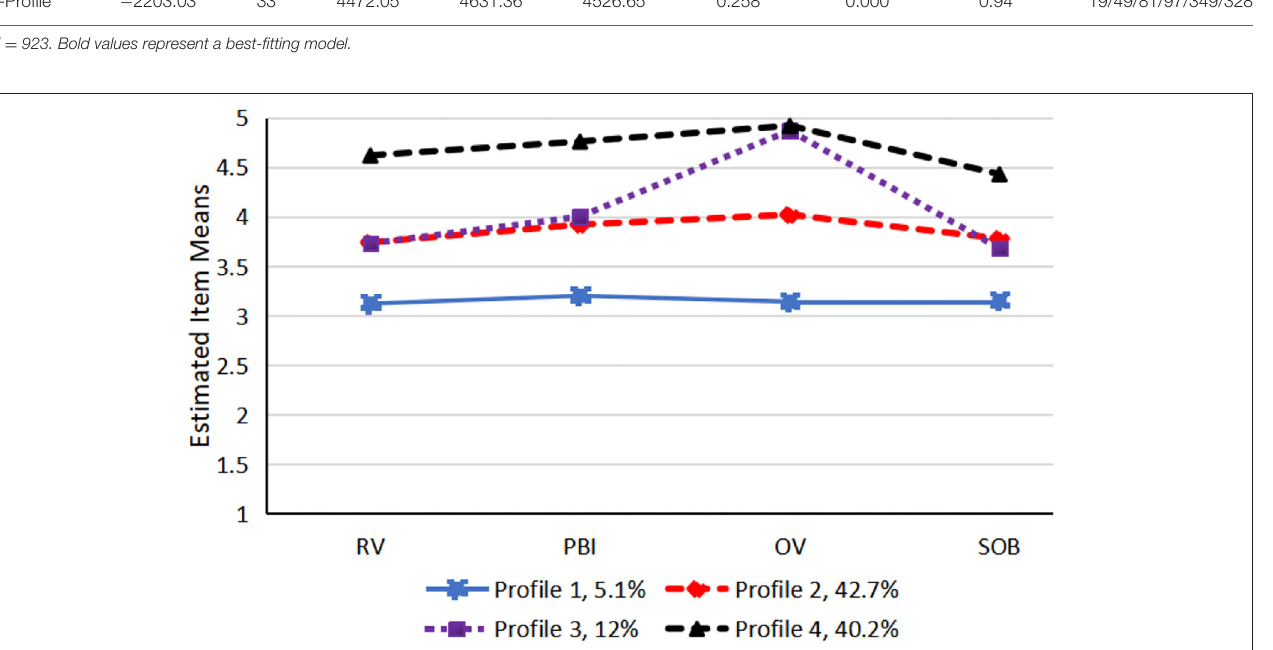
FIGURE 1 | Four-profile solution of teachers’ professional identity. RV, role values; PBI, professional behavior inclination; OV, occupational values; SOB, sense of occupational belonging.